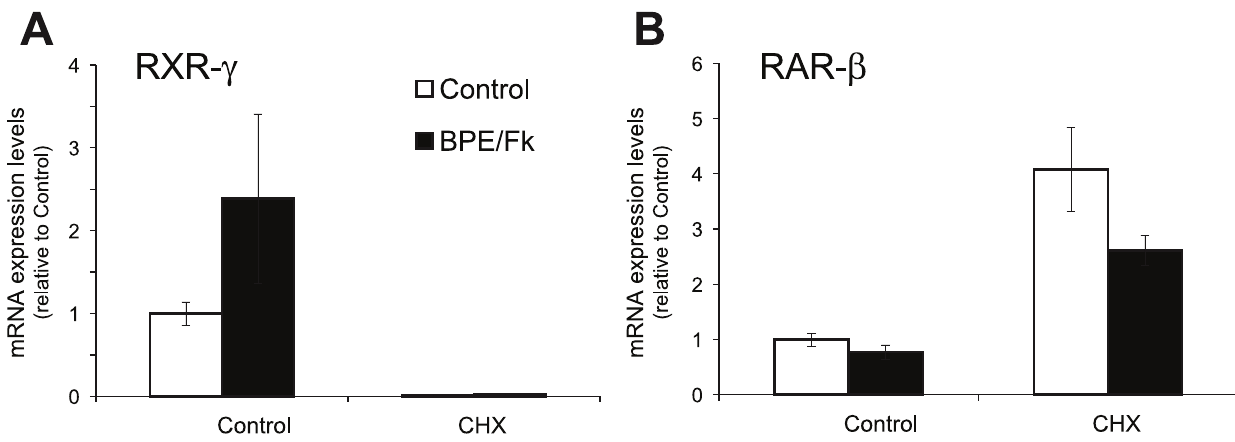
Figure 3. Protein synthesis inhibition abrogates RXR- c , while increasing RAR- b mRNA steady state mRNA levels. SCs were treated with the axonal mimickers forskolin and BPE for 24 hours in the presence or absence of 10 m g/ml of the protein synthesis inhibitor cycloheximide (CHX), and RXR- c ( A ) and RAR- b ( B ) mRNA levels were determined by Q-RT-PCR. All values are shown as the mean 6 SEM relative to their respective controls in the absence of cycloheximide.